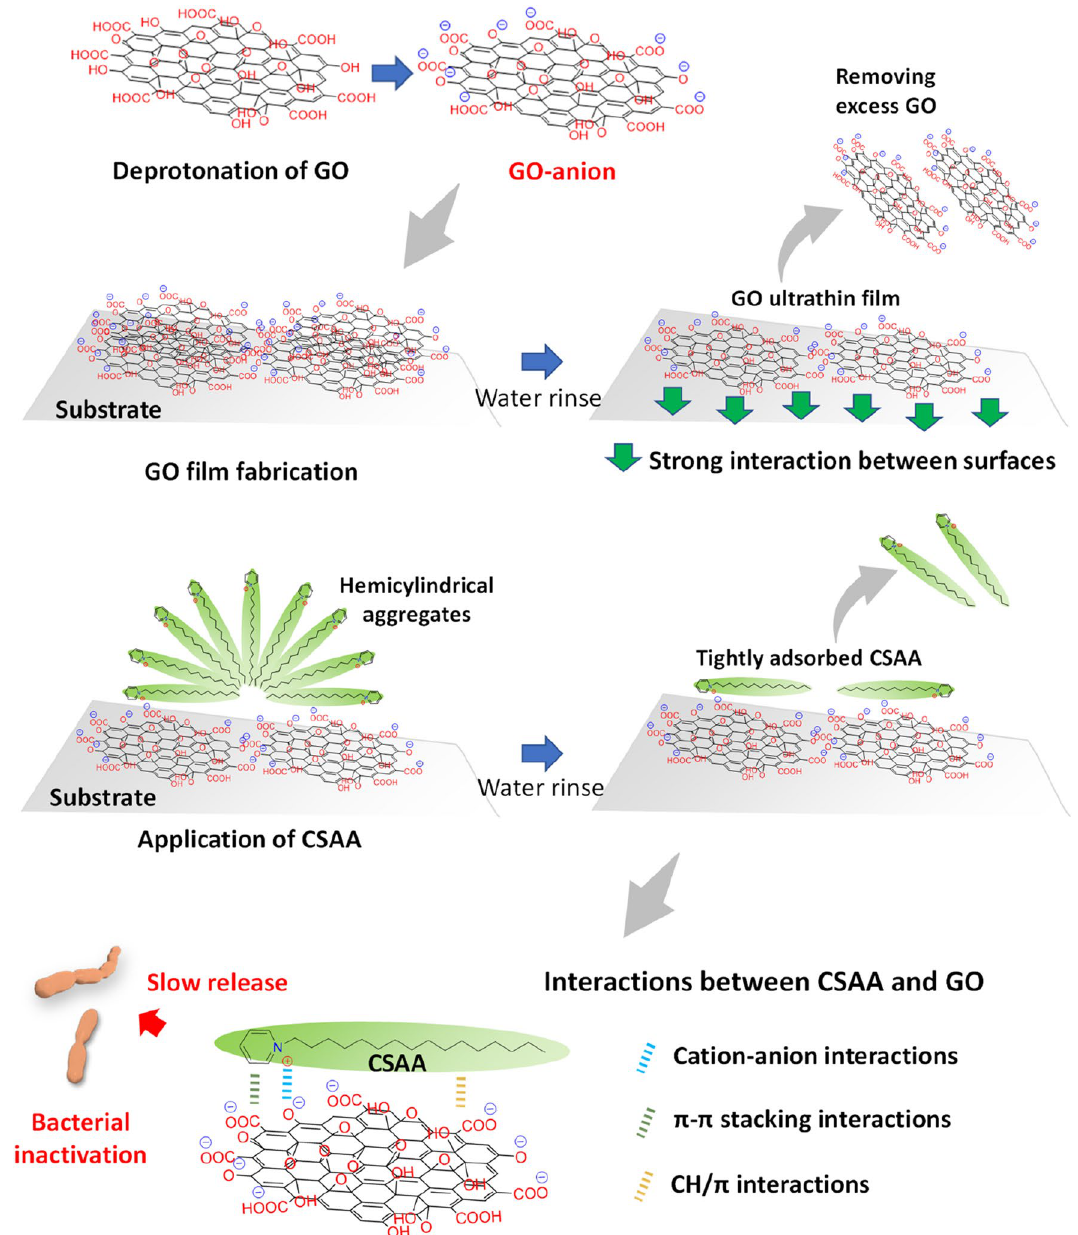
Figure 5. Schematic representation of the mechanism of water resistance and antibacterial action of GO/CSAA. CSAA cationic surface active agent, GO graphene